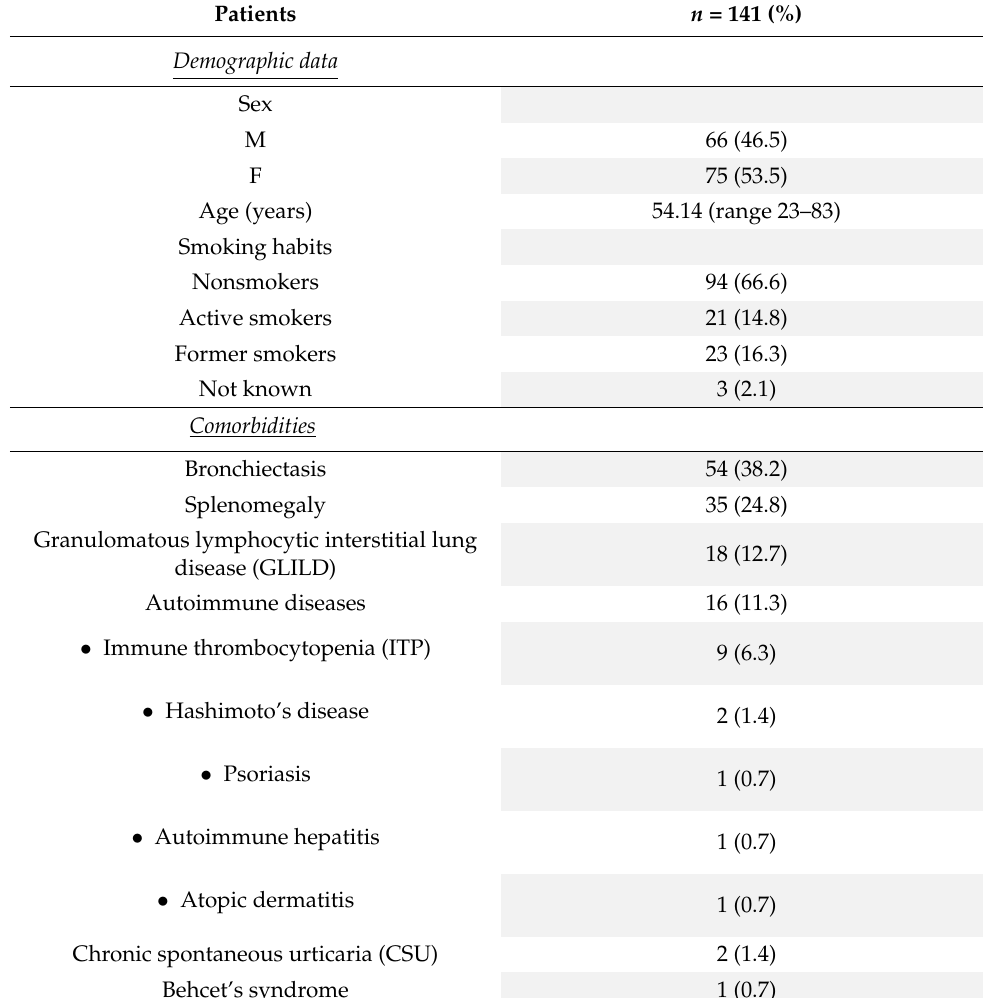
Table 2. Demographic data and comorbidities at